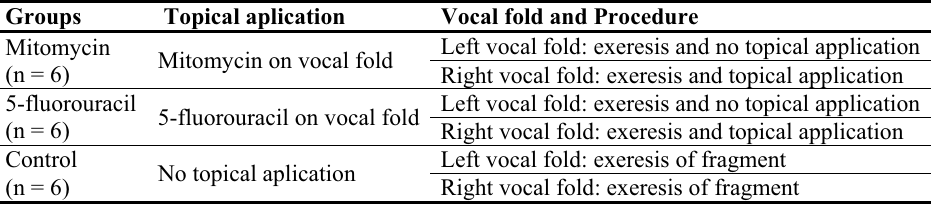
TABLE 1 – Experiment’s design and sample